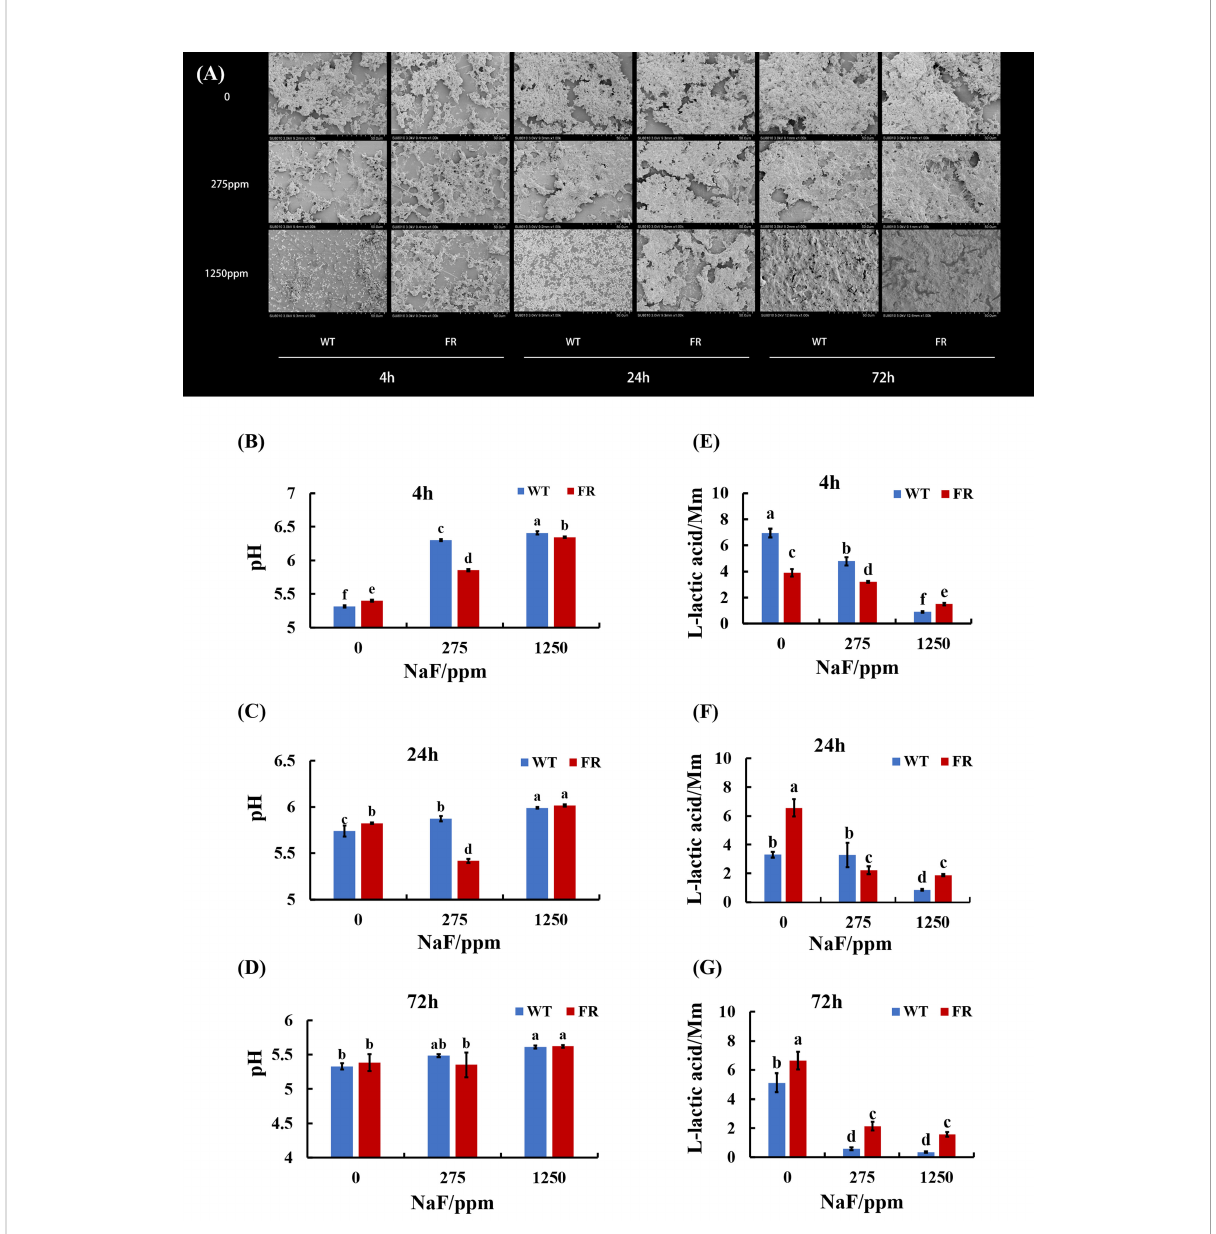
FIGURE 2 Bio fi lm structure and acid production. (A) SEM images of bio fi lms, scale bar 50 m m. (B-D) Supernatant pH of bio fi lms. (E-G) Lactic acid generation of bio fi lms. Data are presented as mean ± standard deviation, and different letters demonstrate a signi fi cant difference between groups (P <